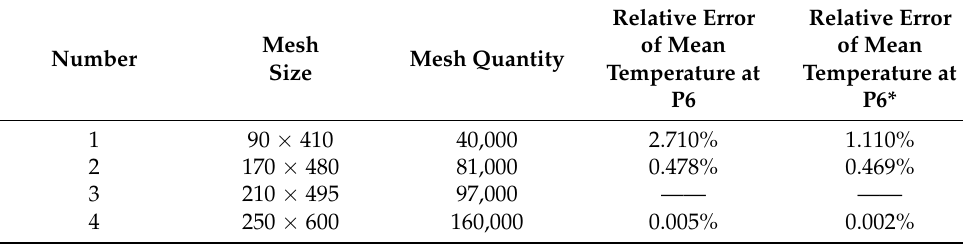
Table 1. Grid independence verification.